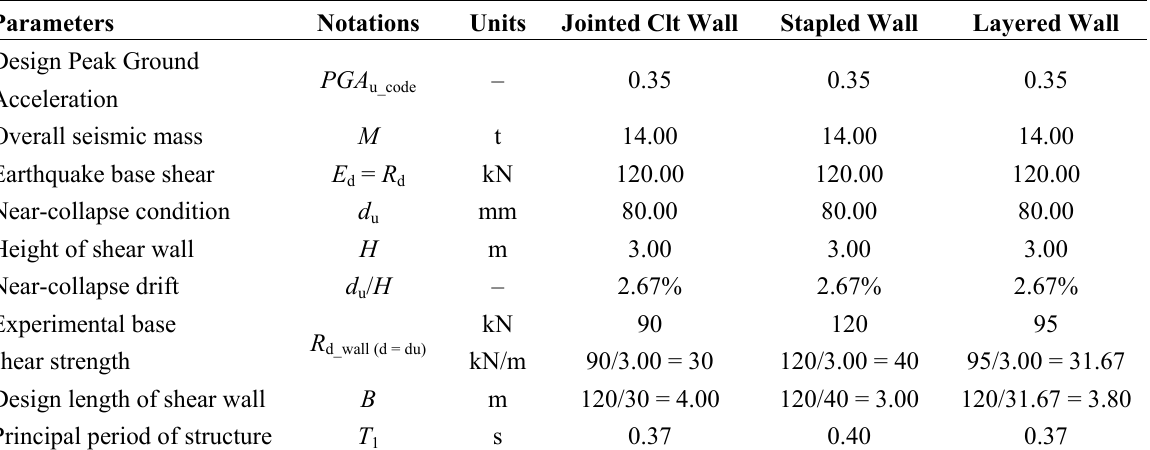
Table 4. Parameters used for wall